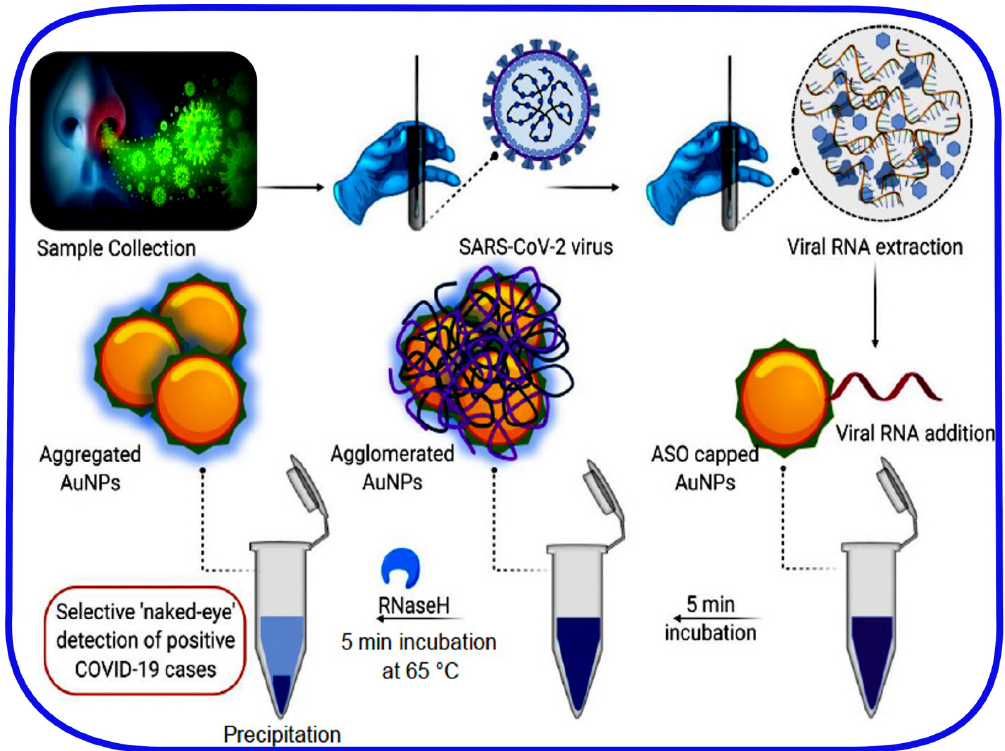
Figure 11. Mediation of SARS‐CoV‐2‐RNA detection using suitably designed antisense oligonucleotides (ASOs)‐capped gold nanoparticles (AuNPs). Figure adapted from [83]. (Further permissions related to this figure should be directed to the ACS https://doi.org/10.1021/acsnano.0c03822).